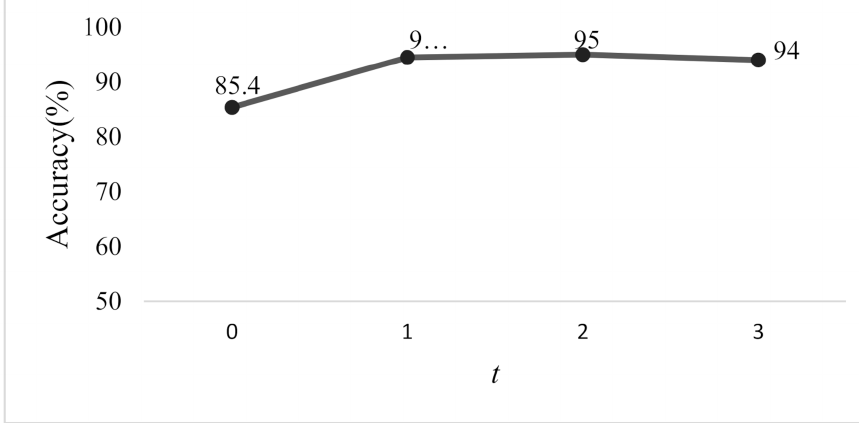
Figure 13. Recognition rates of different time delay